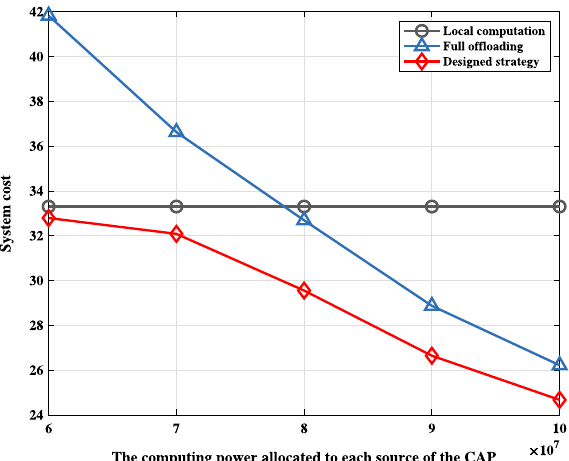
Fig. 7 The influence of the computing power allocated to each source of the CAP on system